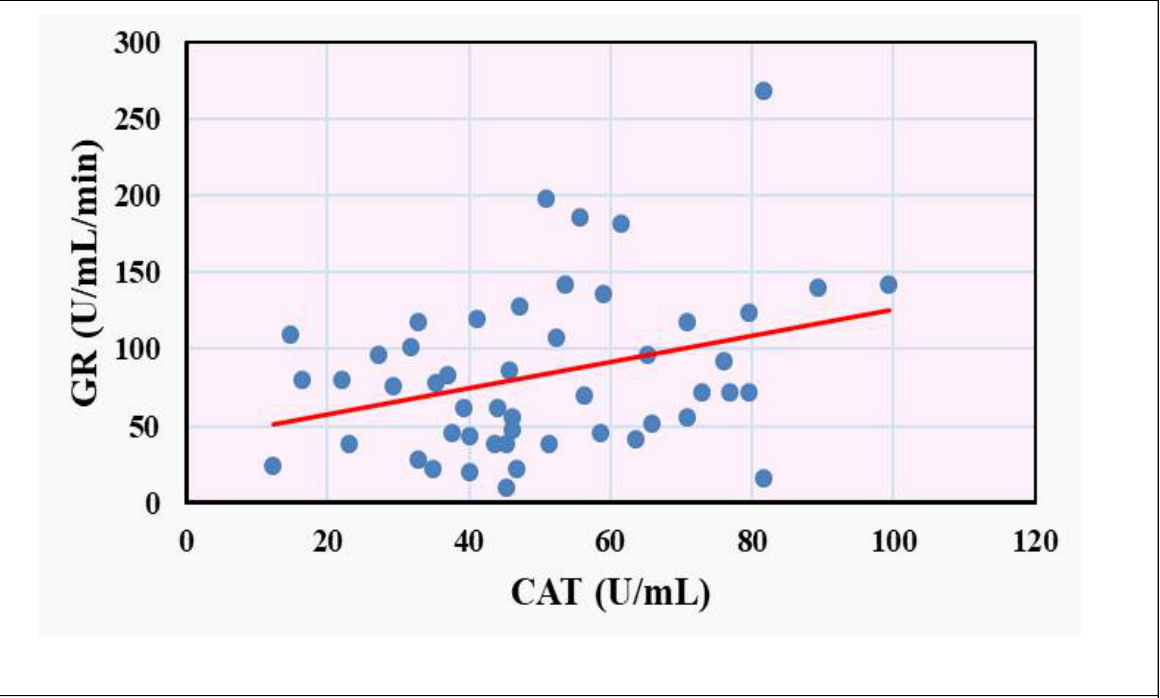
Figure 4: A significant, direct correlation between circulatory glutathione reductase (GR) and catalase (CAT) activities in ACS patients ( r = 0.324, p < 0.05, Spearman correlation